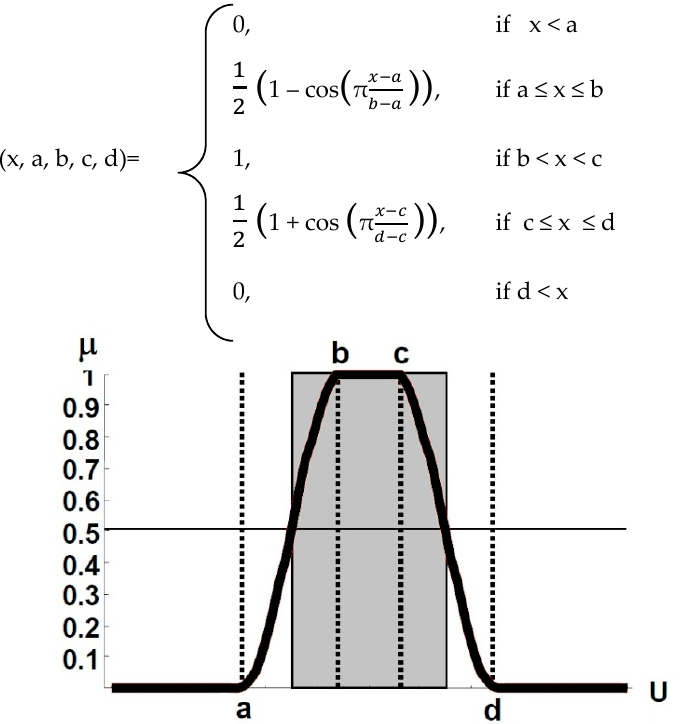
Figure 2. Sinusoidal membership function